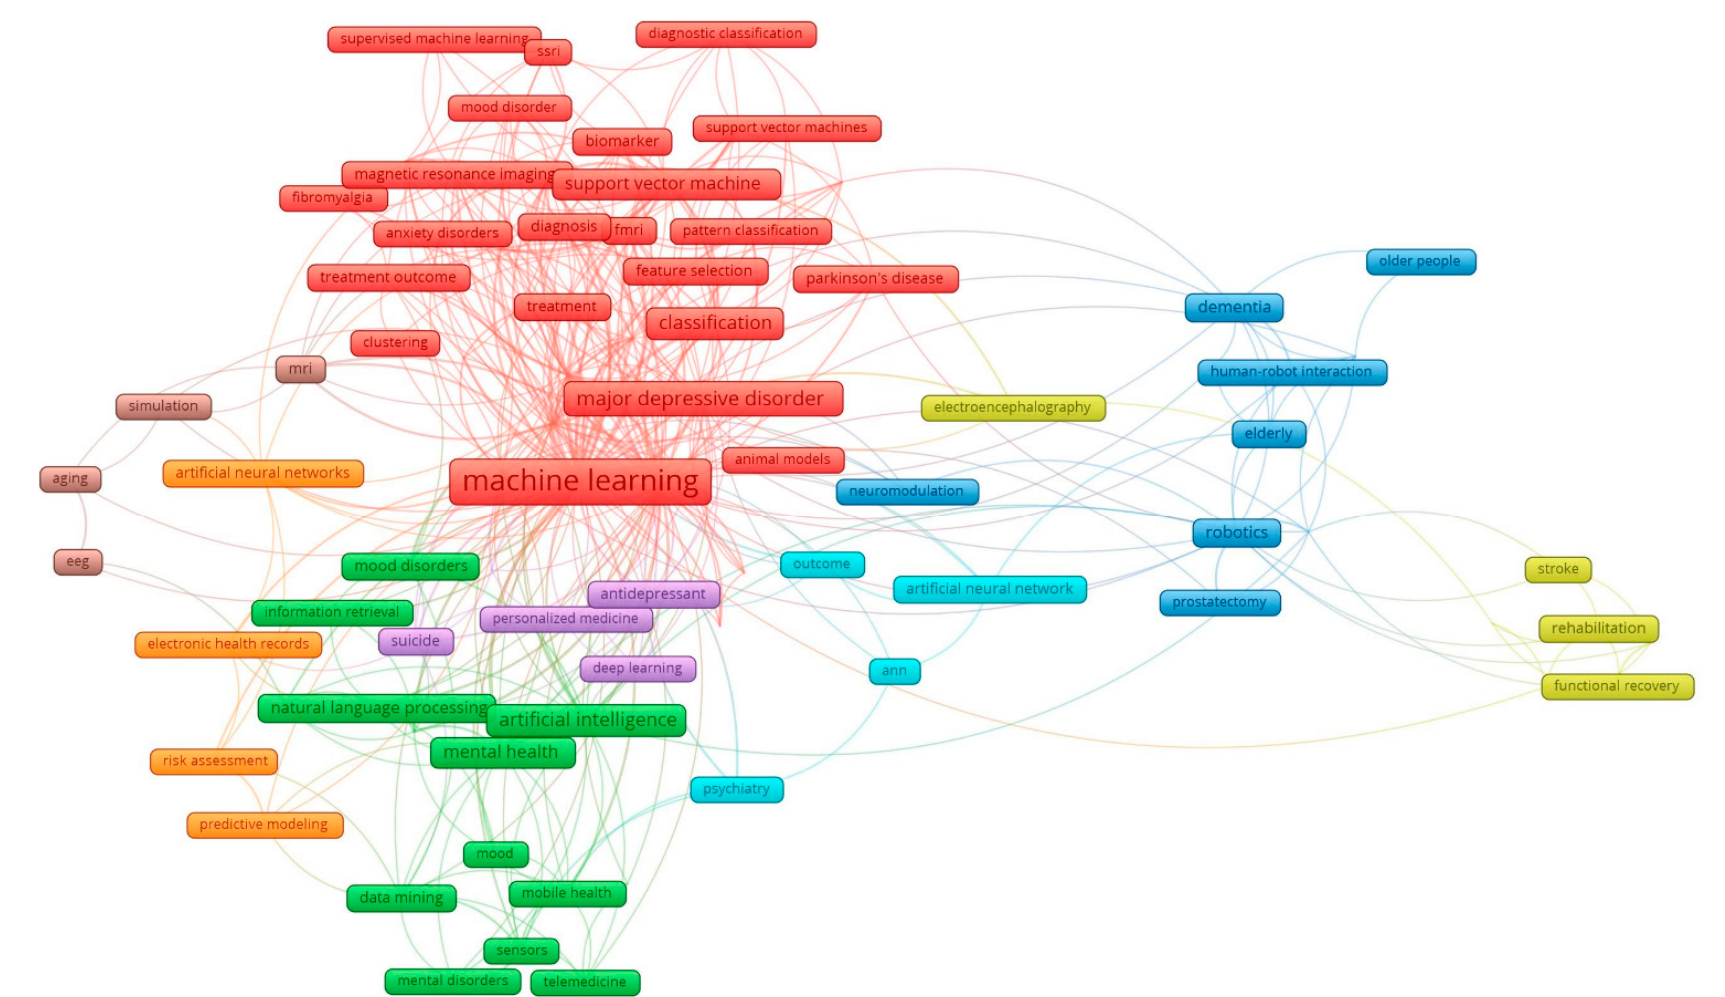
Figure 2. Co-occurrence of most frequent research keywords. Note: the colors of the nodes indicate principle components of data structure. The nodes’ size was scaled to the keywords’ occurrences. The thickness of the lines was drawn based on the strength of the association between two keywords.